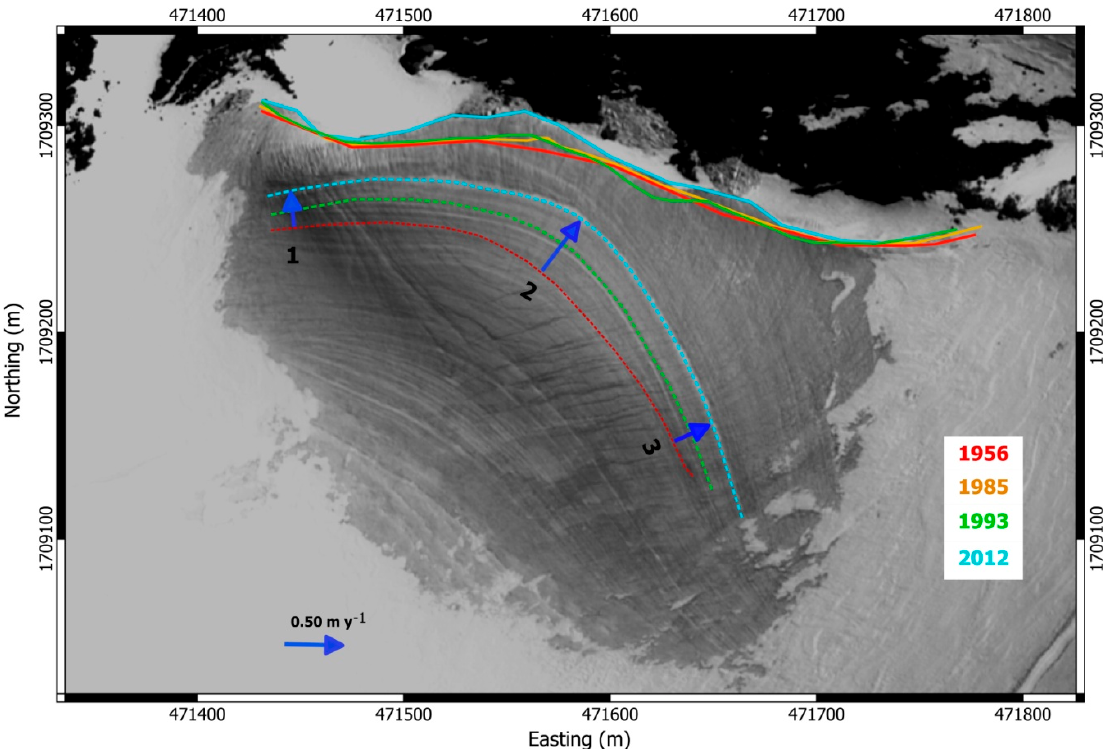
Figure 5. Multi-temporal signature of ice body advancement (dashed lines) and of surface stratification (dotted lines) on Strandline Glacier.